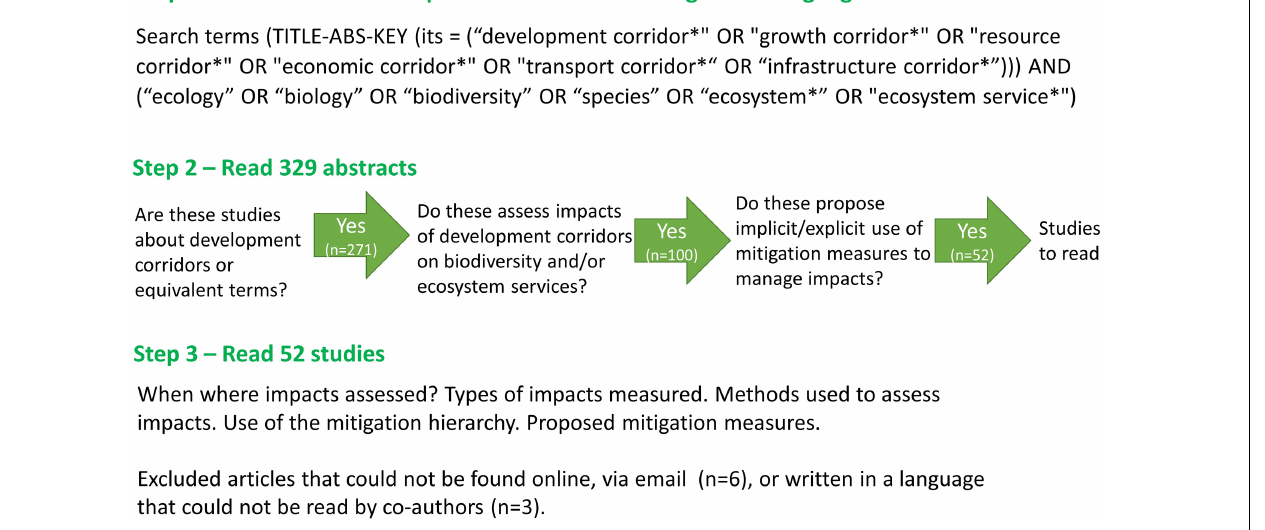
FIGURE 2 | Steps of rapid evidence review including search terms, screening and inclusion and exclusion